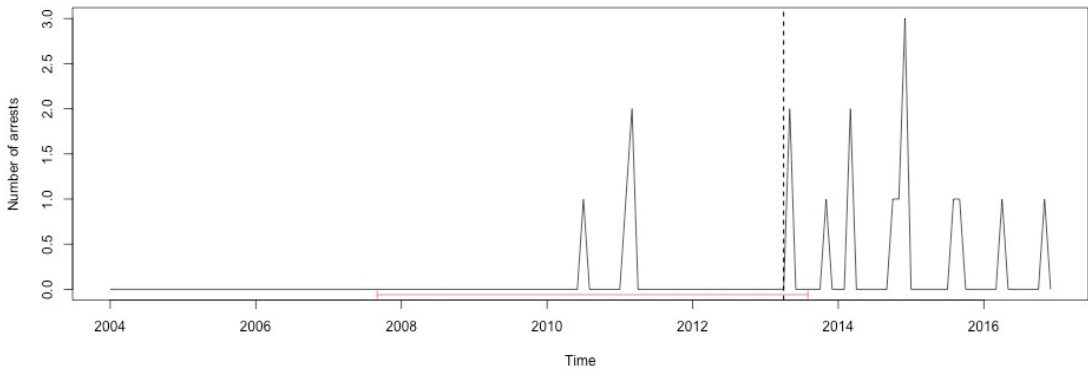
Figure A34. Precursor Vietnamese arrests 2004–2016 in the Czech Republic and structural breaks.